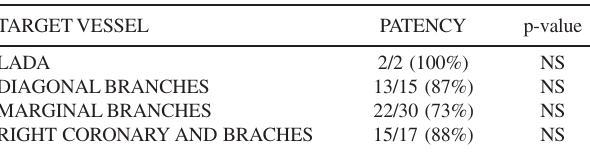
NS: Chi-square test with no significant difference. LADA: left anterior descending artery.Figure 1 - Three dimensional computed tomography image for Left Internal Thoracic Artery to Left Anterior Descending Artery (LITA – LADA) and Radial Artery to marginal branches 2 and 3 (RA – MG2; RA –